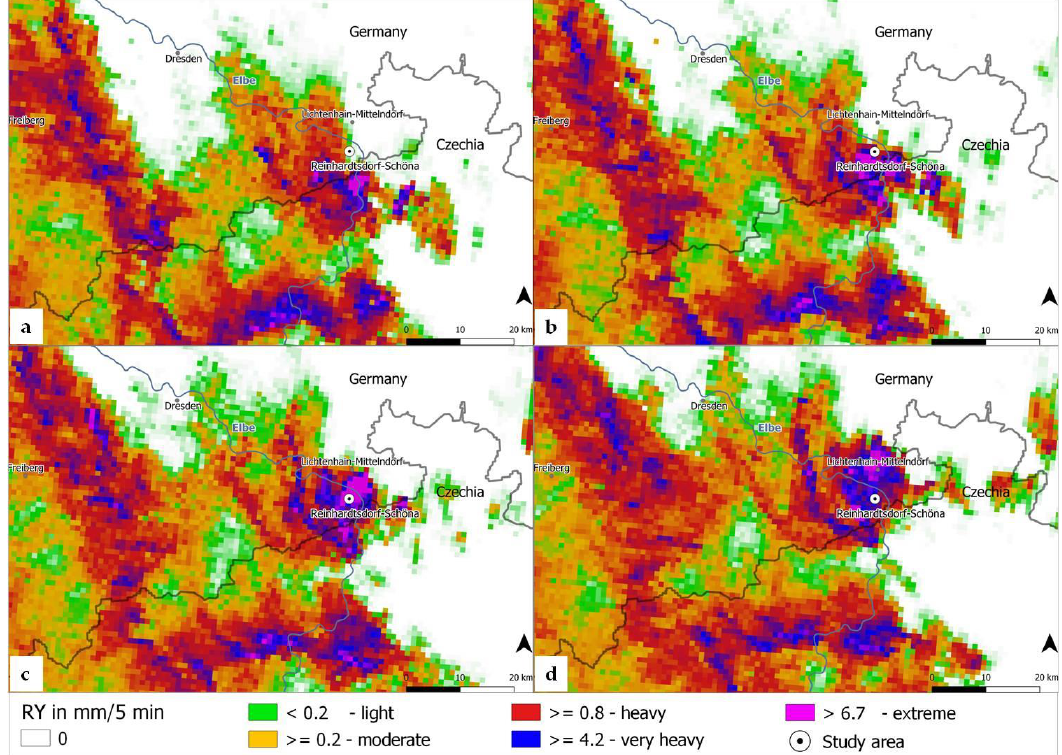
Figure 8. The selected storm event in 5-min time steps on 23 May 2016 from ( a ) 7:10 p.m., ( b ) 7:15 p.m., ( c ) 7:20 p.m. to ( d ) 7:25 p.m.